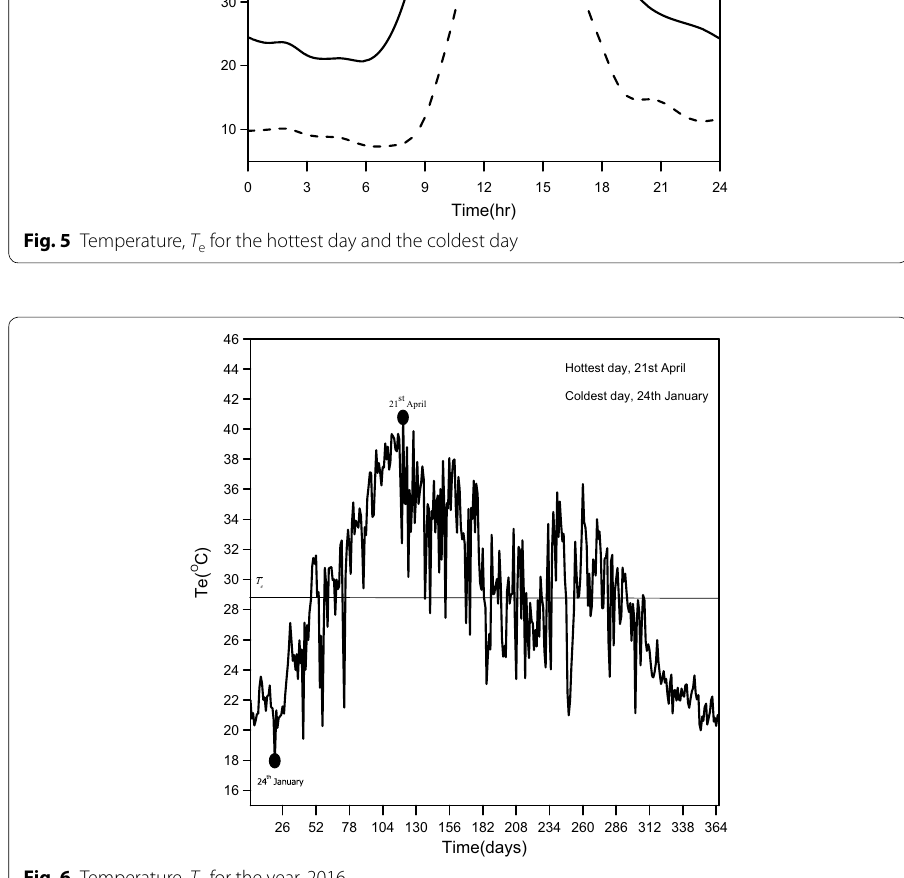
Fig. 6 Temperature, T e for the year,